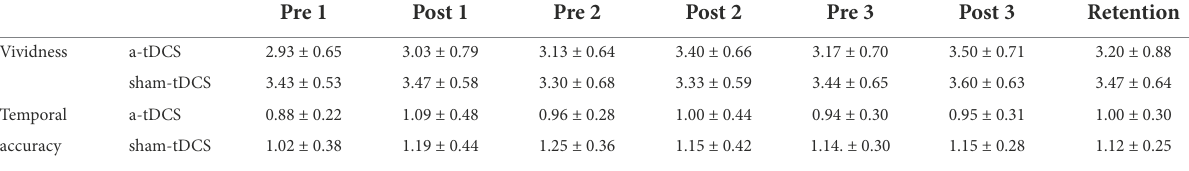
TABLE 2 Task-specific MI